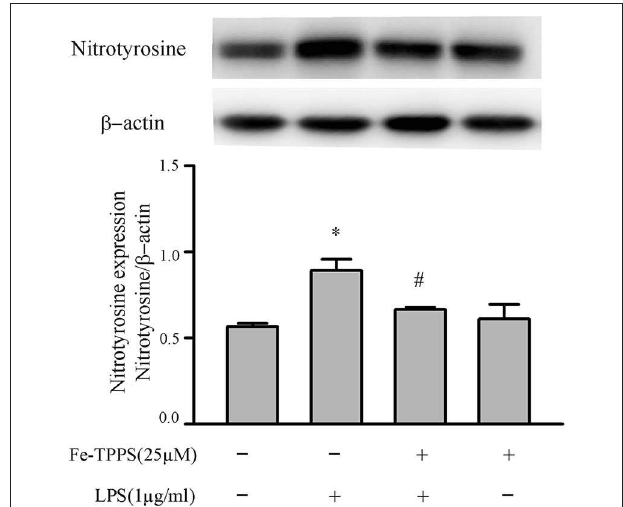
FIGURE 6 | Fibroblast nitrotyrosine levels are increased by a LPS challenge, an effect prevented by a peroxynitrite decomposition catalyst (Fe-TPPS). Fibroblasts were pretreated with Fe-TPPS (25 µ M) or vehicle for 30min and subsequently challenged with LPS for 15min. Nitrotyrosine levels were assessed by Western blot. Representative blots are shown in upper panel and densitometric analysis in lower panel. n = 3, * p < 0.05 as compared with control; # p < 0.05 as compared with